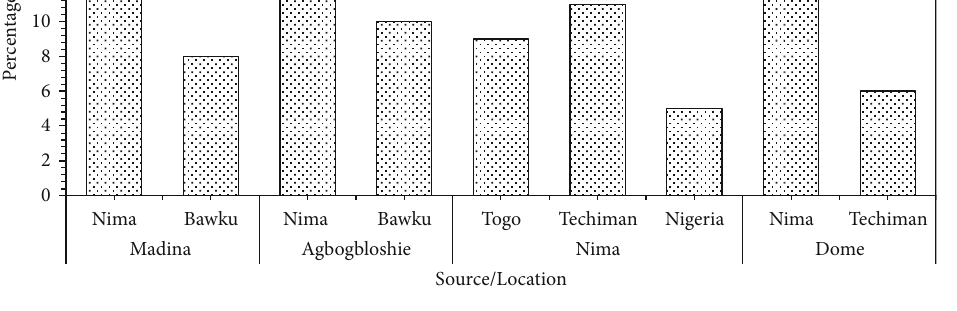
Figure 1: Sources of melon seed supply.